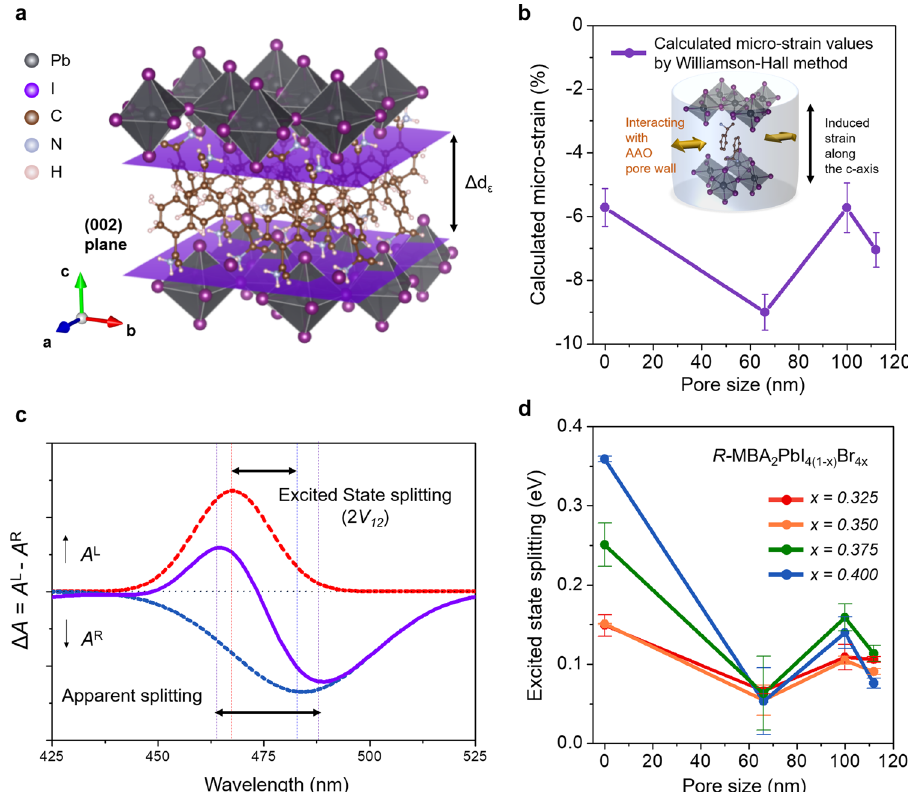
Fig. 2 Estimation of micro-strain in chiral 2D OIHPs and stacking conformation variation induced by micro-strain. a Schematic illustration of unit cell of R-MBA 2 PbI 4 and induced change of d -spacing between the (002) planes. b Magnitude of calculated micro-strain values as a function of AAO template pore size. The inset represents the schematic illustration of nanocon fi ned growth of chiral 2D OIHPs in AAO template. The black arrow indicates the change in the lattice parameter along the c -axis. c Deconvolution results obtained from the CD spectra. The solid purple line represents obtained CD spectra from the chiral 2D OIHPs. The red and blue dot-line indicate the absorption of LCP and RCP, respectively. d Plot of excited state splitting values versus AAO template pore size. Error bars indicate the standard deviation. Note that the 0 nm pore size condition represents chiral 2D OIHPs grown on planar substrate without